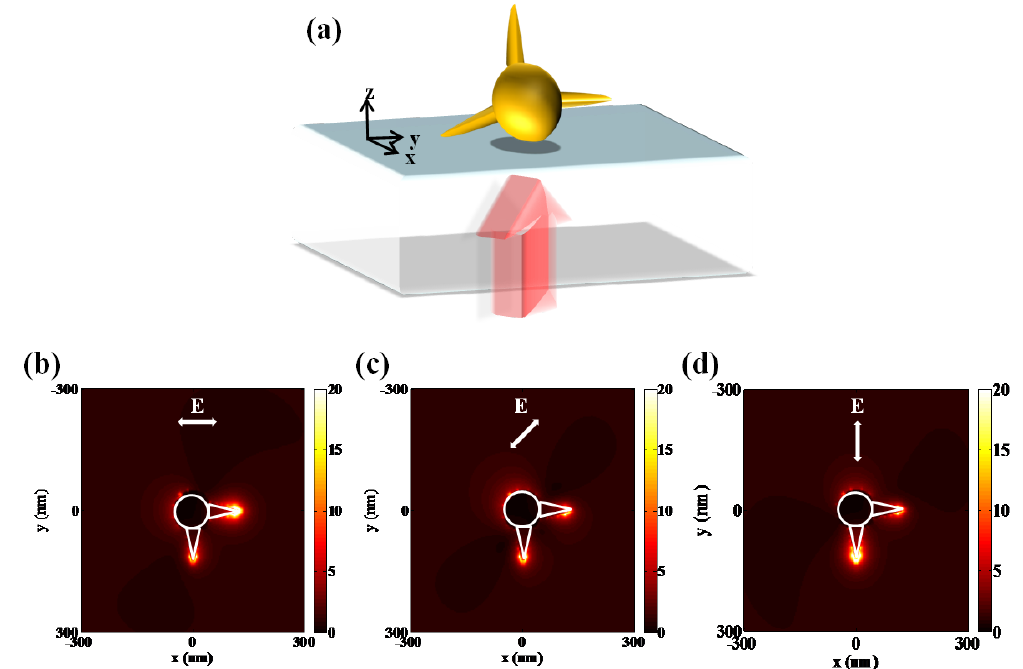
Figure 9. (a) Schematic of simplified nanostar placed onto a glass substrate. Electric field distributions at a distance of 10 nm from a nanostar when illuminated by (b) horizontally polarized light; (c) 45° polarized light; and (d) vertically polarized